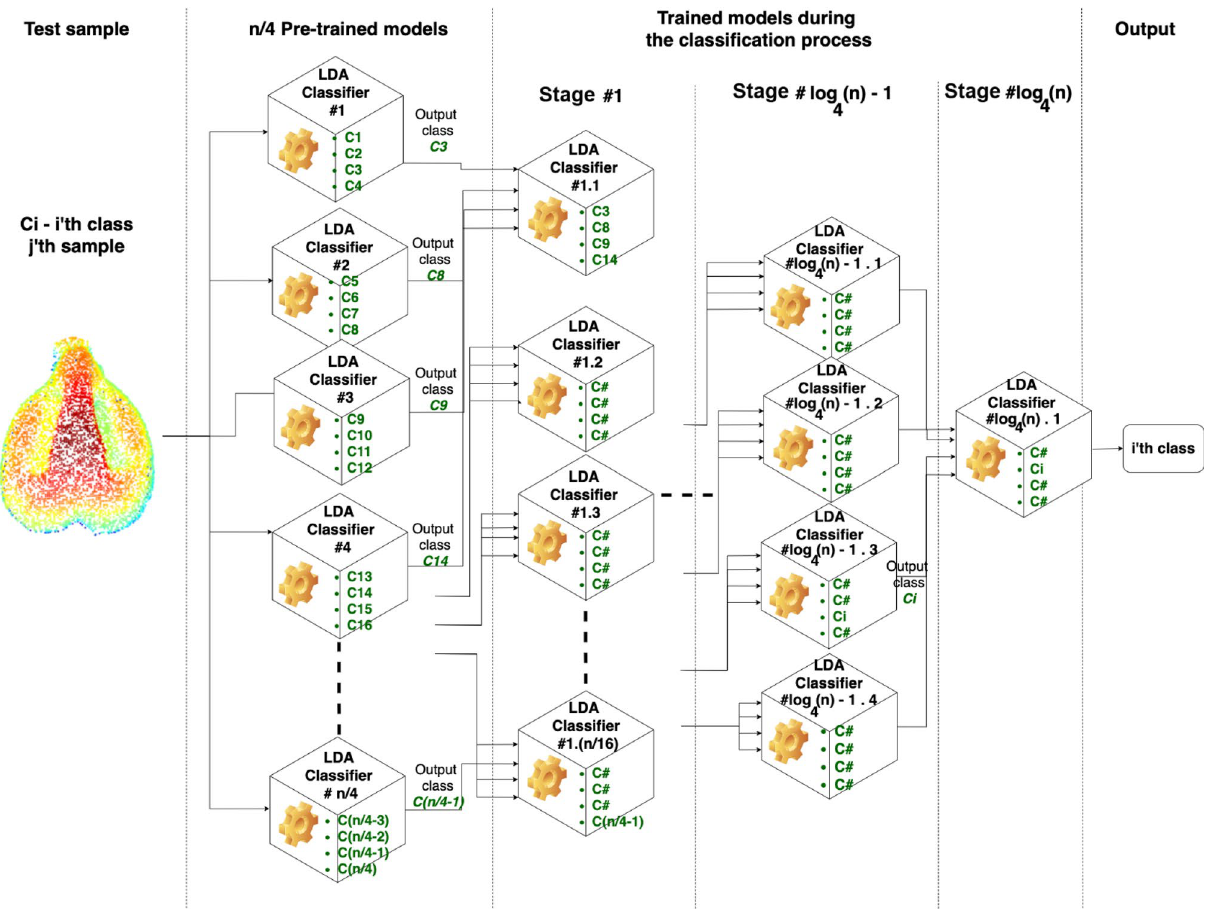
Figure 9. General demonstration of a “tournament” classification flow and its internal stages of training and classifications down to the final identification result. The test sample may be an unidentified charred grape